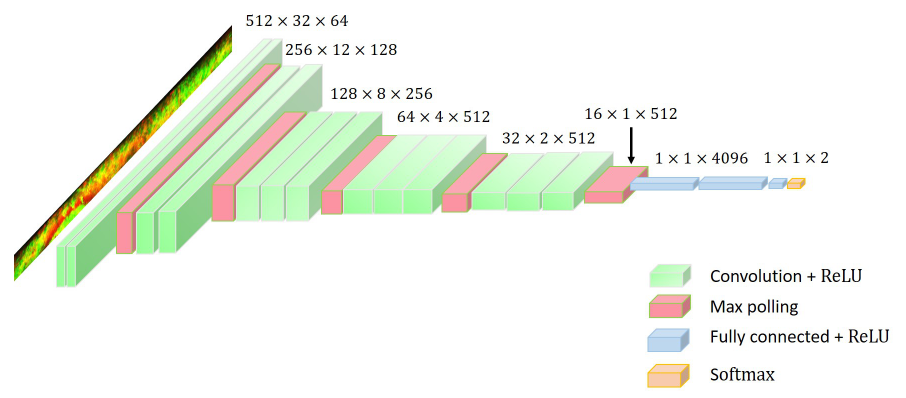
Figure 1. Architecture of VGG16 used in our left–right irises’ classification